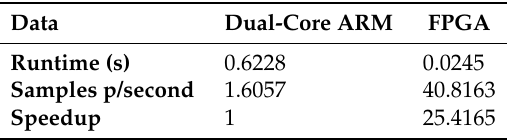
Table 4. Runtime of the complete system.